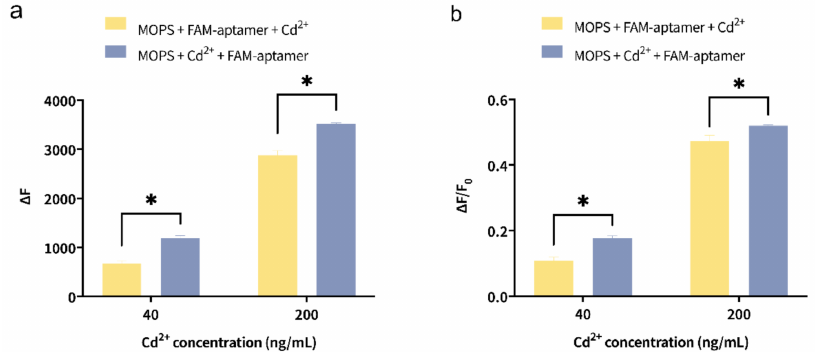
Figure 2. Effect of addition order on ( a ) fluorescence quenching ( ∆ F ) and on ( b ) fluorescence quenching efficiency ( ∆ F / F 0 ). * indicates significant difference ( p < 0.05, n ≥